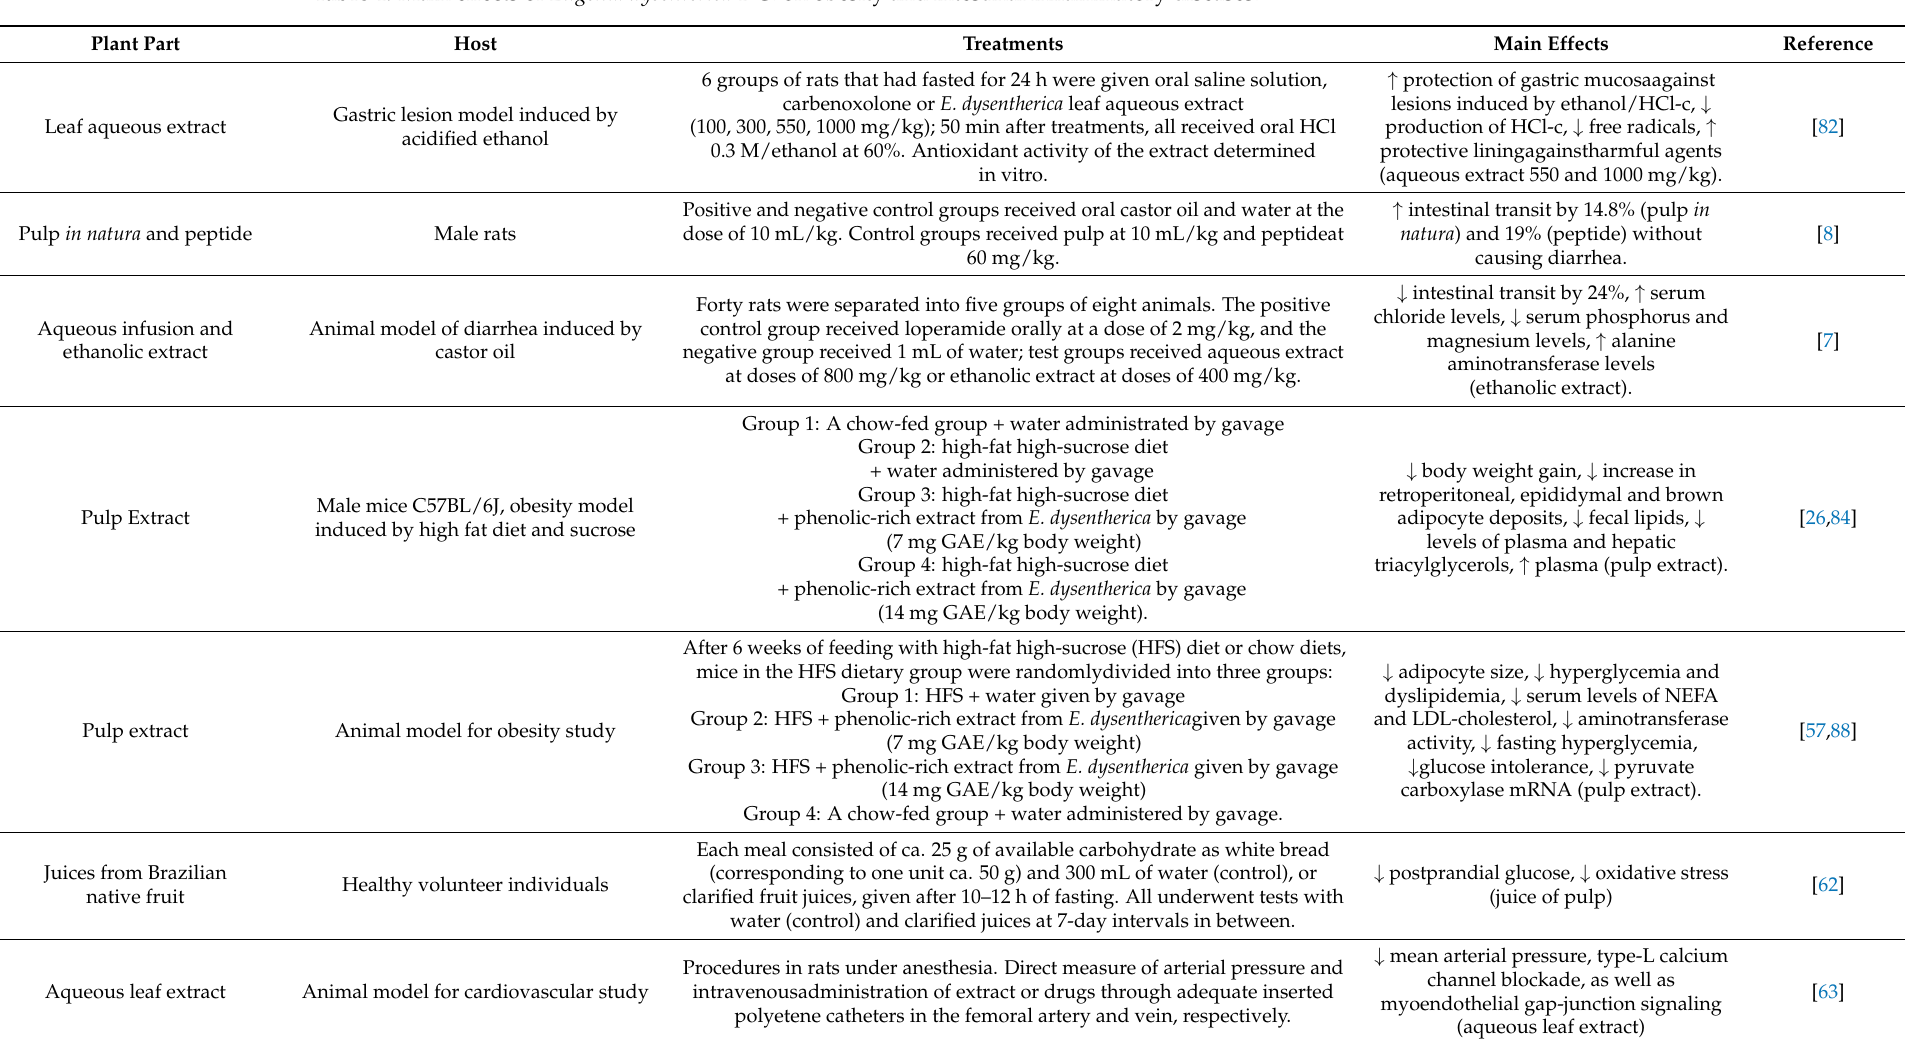
Table 4. Main effects of Eugenia dysenterica DC. on obesity and intestinal inflammatory